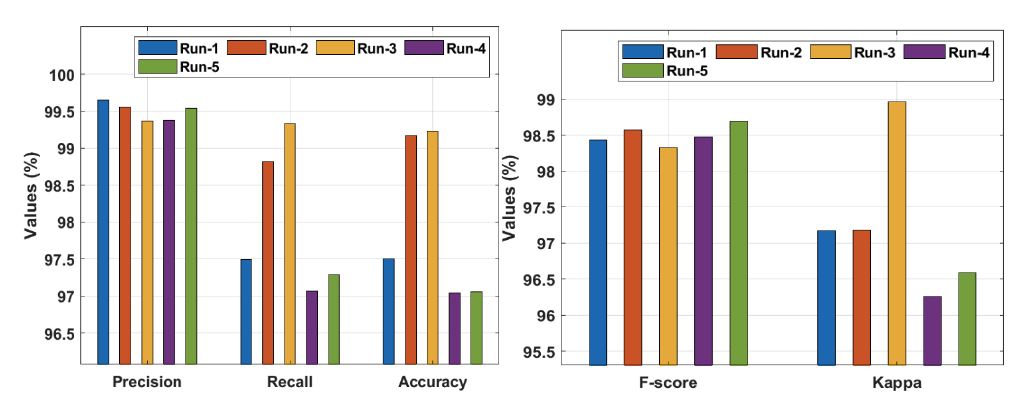
Fig. 2. Result analysis of the EMACC-MR Method on the Pima Indian Diabetes Dataset, (b)F-score and kappa analysis of the EMACC-MR Method on the Pima Indian Diabetes Dataset